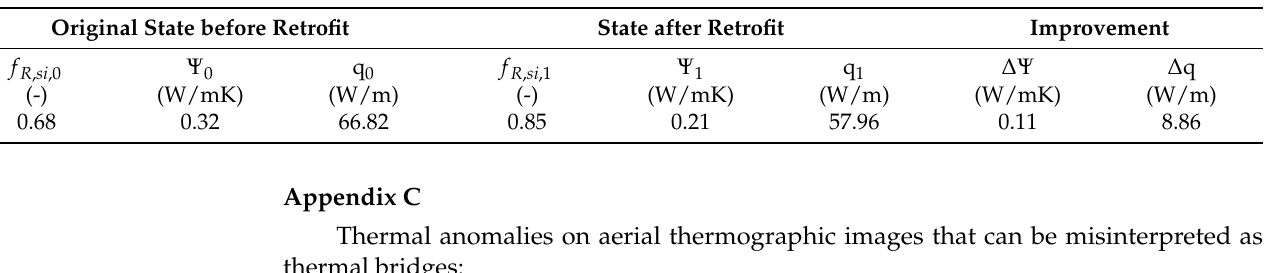
Table A31. Quantifiable results of the thermal bridge retrofit of a connection between a rooftop and a wall (ThermCad thermal bridge simulation